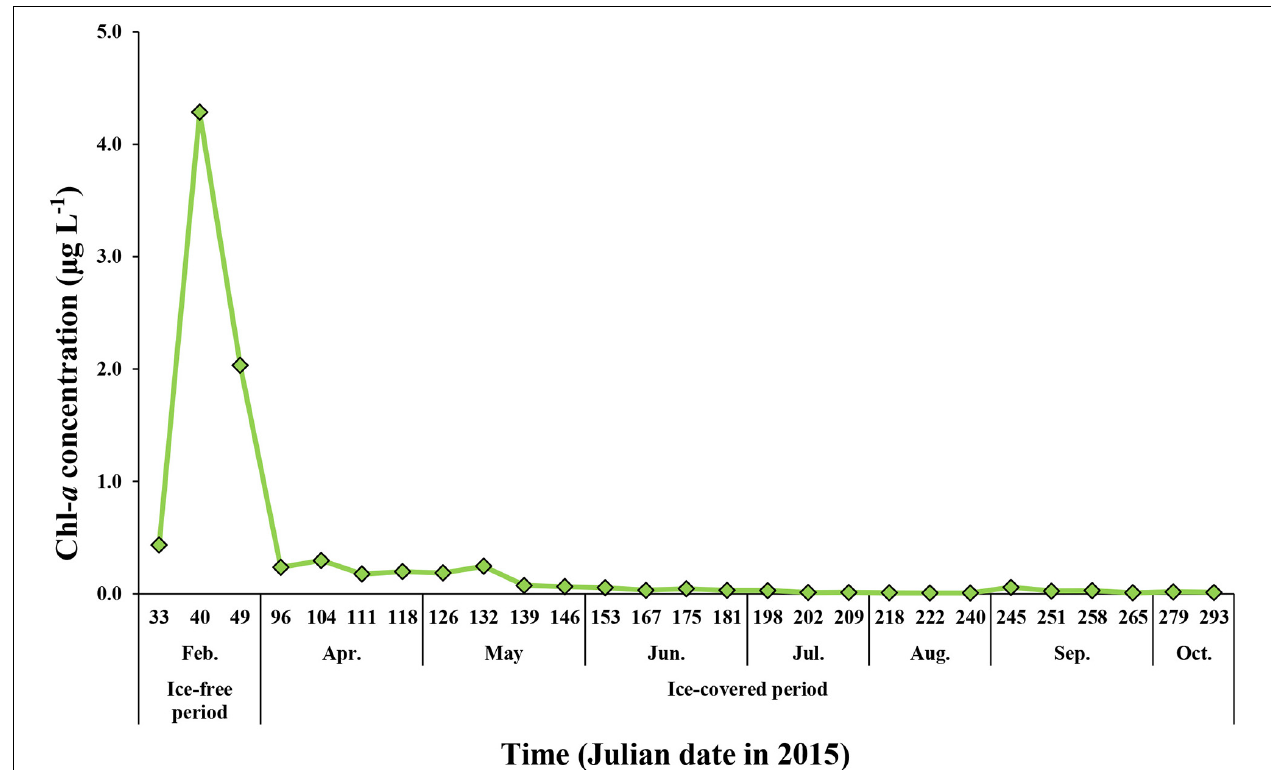
FIGURE 5 | The Chl- a concentration for total ( > 0.7 µ m) phytoplankton at JBS during the entire study period,